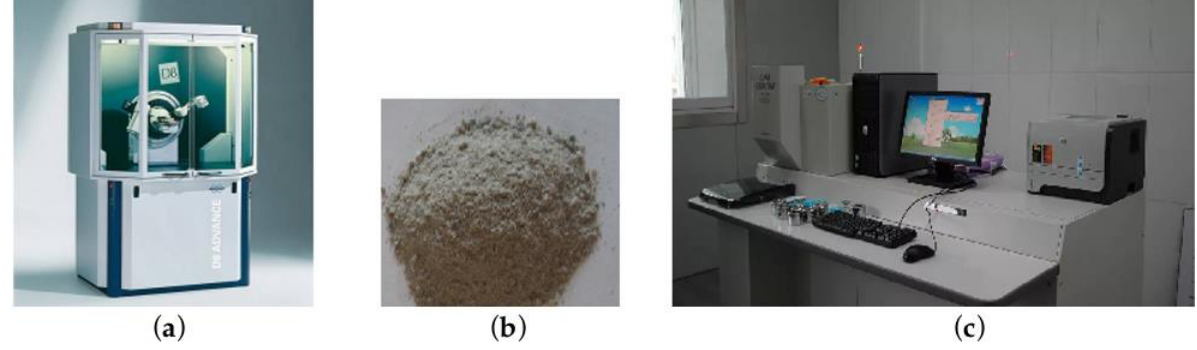
Figure 4. Examination equipment and material: ( a ) diffractometer Bruker D8 ADVANCE; ( b )